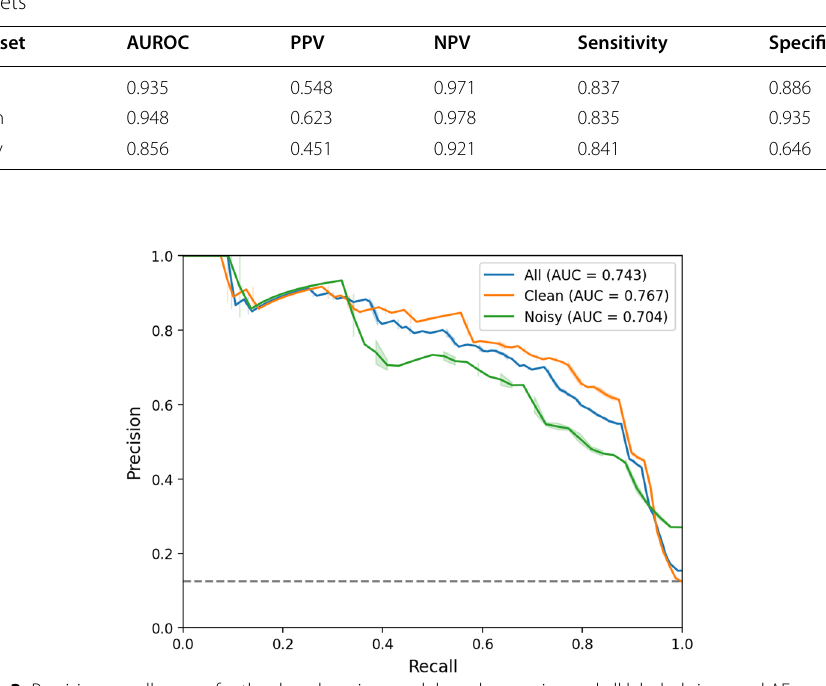
Fig. 3 Precision–recall curves for the deep learning model on clean, noisy, and all labeled sinus and AF samples from the KGH dataset. The dashed gray line represents the expected performance of a random baseline classifier, i.e., the prevalence of the positive (AF)